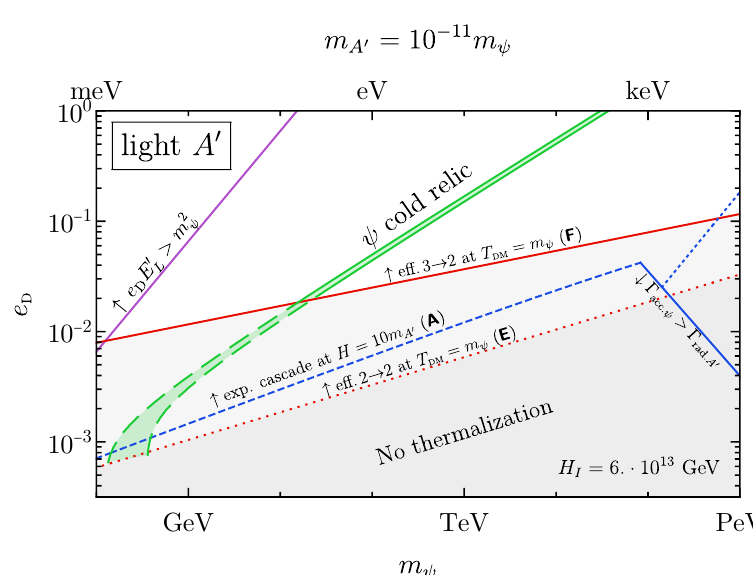
Figure 16. Region where ψ can be efficiently produced in the case of very light A 0 . The blue dashed lines mark where an exponential cascade process can take place before a ? (we choose the time when H = 10 m A 0 ), even if the condition e d E 0 > m 2 is not satisfied. The dark photon L, vac ψ mass m A 0 can be pushed down to about 10 − 16 m ψ before the blue line moves above the solid green one, implying that the dark sector cannot reprocess its energy on the relic density line, and that ρ A 0 would follow the usual prediction of